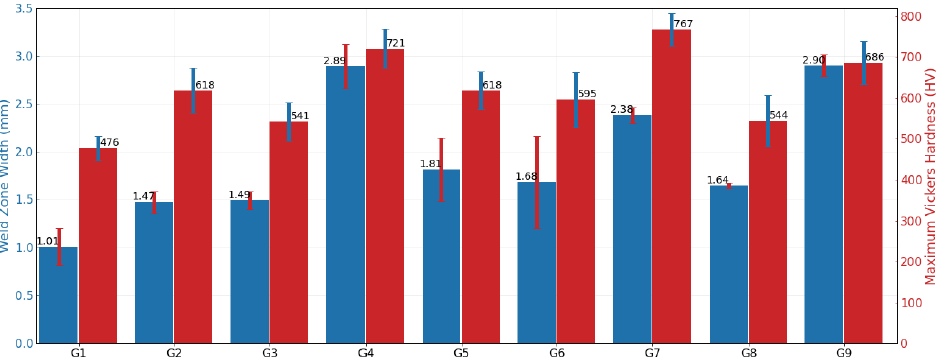
Figure 5. Weld zone width and maximum Vickers hardness of each welded joint.